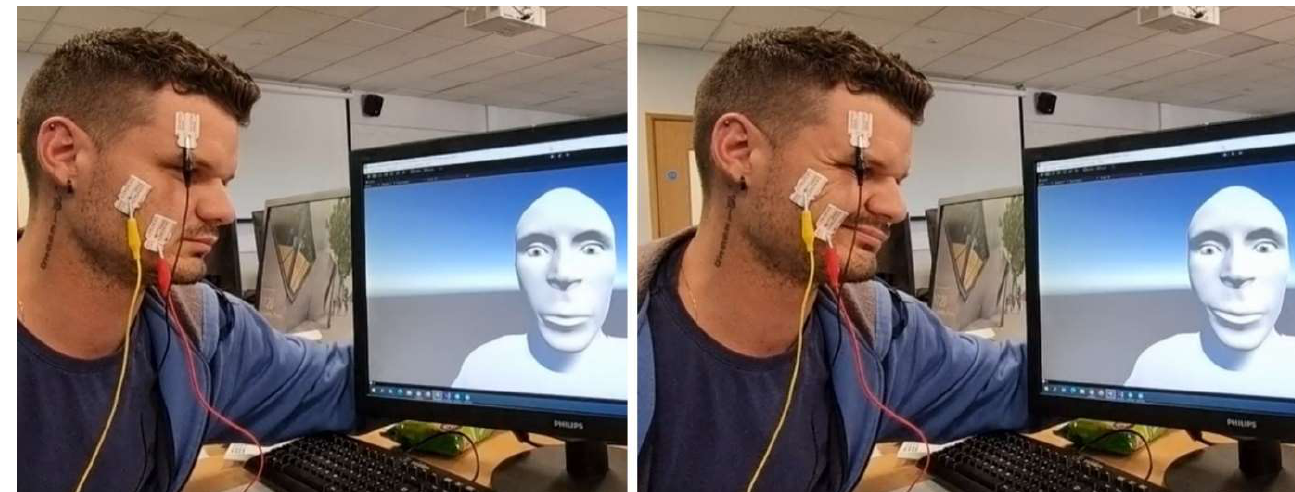
Figure 10. Testing the EMG data controlling a 3D animation in real time in Unity application. As shown in these images, the lower right blendshape changes as the user flexes their right zygomaticus muscle with an associated signal increase along scale 1–100.